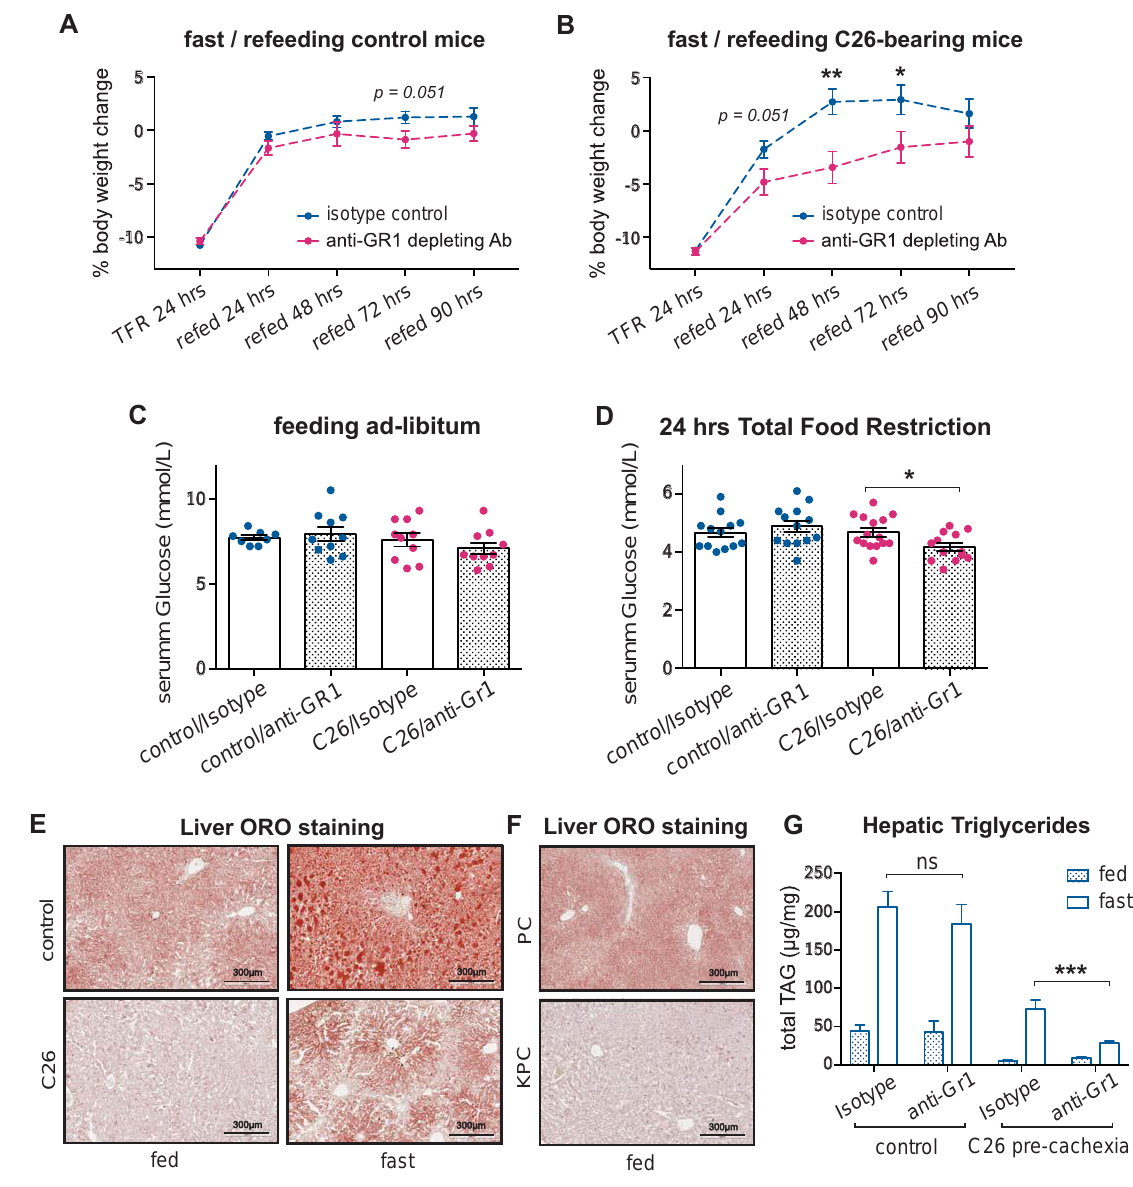
Figure 5. Effect of acute neutrophil depletion during cancer-associated metabolic stress. ( A , B ) Body weight trajectories after TFR of littermates ( A ) and pre-cachectic C26 mice ( B ) that were treated with anti-Gr1 or isotype. ( C , D ) The glucose levels in C26 mice and littermates that were treated with anti-Gr1 or isotype, when fed ad libitum ( C ) and after 24 h of total food restriction (TFR) ( D ); ( E , F ) Lipid staining by Oil Red O in the liver of fed or fasted pre-cachectic C26 mice and littermates ( E ) and the fed pre-cachectic KPC mice and the PC controls ( F ); ( G ) Quantification of triglycerides by liquid chromatography-mass spectrometry in the liver of fed and fasted pre-cachectic C26 mice and littermates that were treated with anti-Gr1 or isotype. The data are expressed as the mean ± SEM. Unpaired two-tailed Student’s t -tests were performed at each time point in ( A , B ), with the Holm– Šid á k method correction for multiple comparisons. One-way ANOVA with Tukey’s correction for post hoc testing was used in ( C , D , G ). * p -value < 0.05, ** p -value < 0.01, *** p -value < 0.001, ns: not